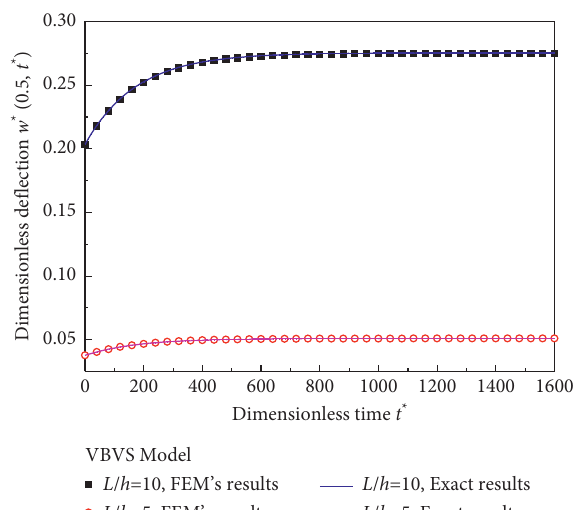
Figure 5: Response of dimensionless midspan deflection w ∗ (0.5, t ∗ ) versus dimensionless time t ∗ of viscoelastic cracked beam with VBVS model.